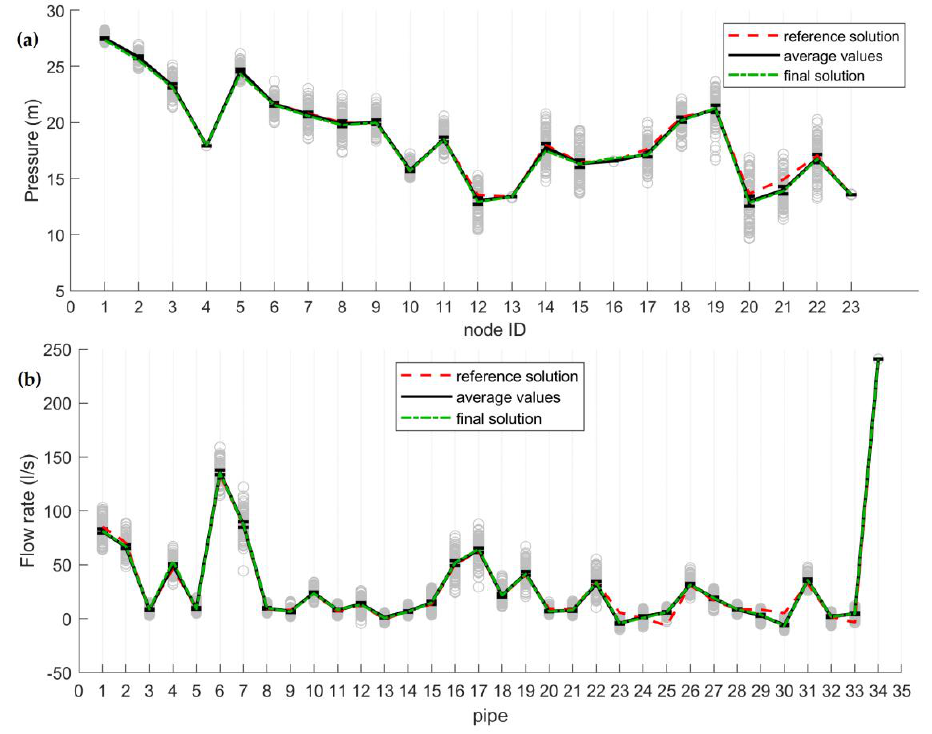
Figure 7. Resulting solution in the Apulian network with the DPD approach. In panel ( a ) are displayed the pressure distribution of the 100 runs, the reference values, the average values and the final one with confidence intervals. The flow rate distribution of the 100 runs, the reference values, the average values and the final one with confidence intervals are displayed in panel ( b ).